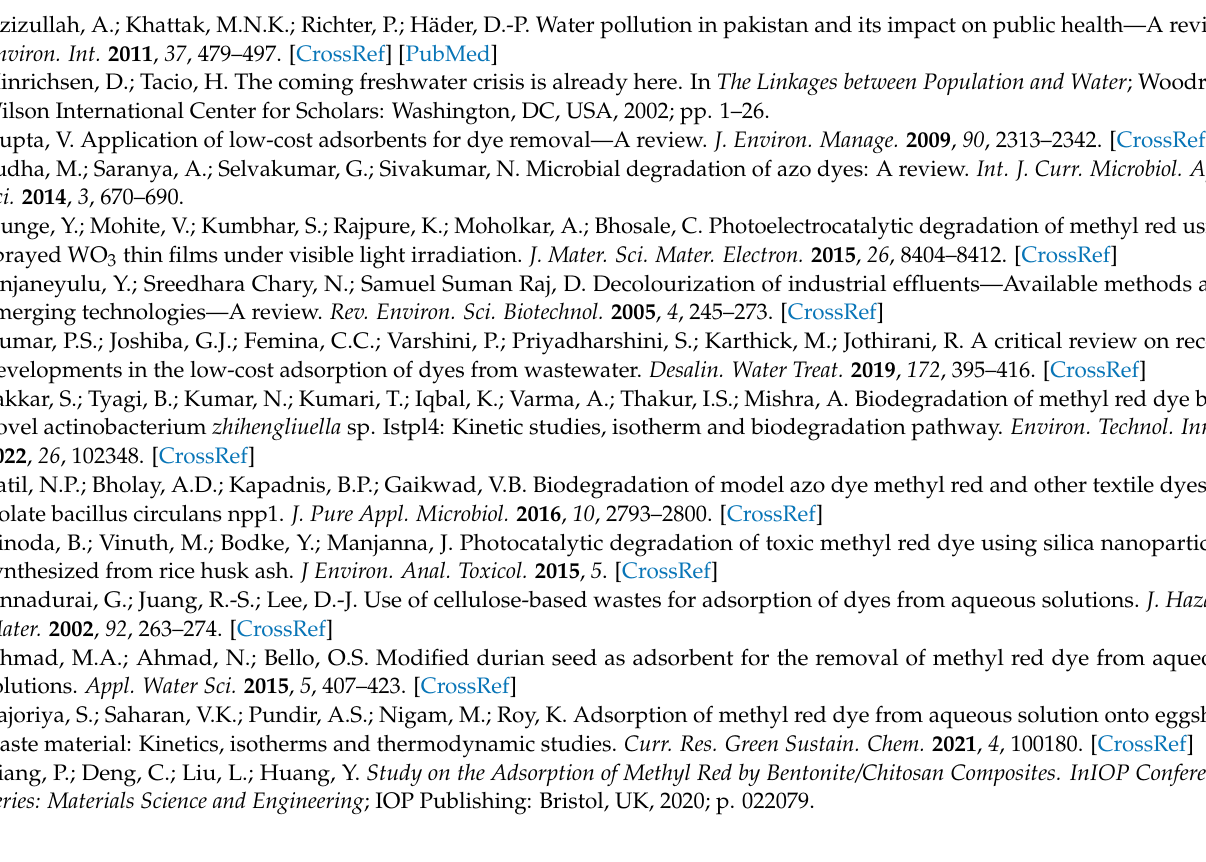
Figure S2: Protonation of methyl red in acidic solutions; Figure S3: Plot of absorbance as a function of wavelength to determine wavelength maximum ( λ max ); Explanation